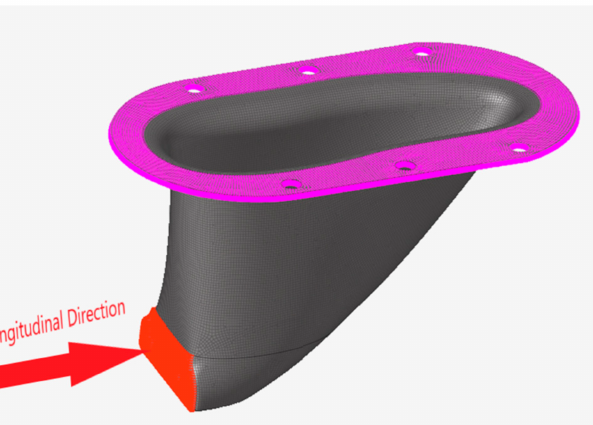
Figure 4. Boundary constraint location at the top of the structure (pink) and load application location on the front, bottom of the structure (red) and the longitudinal load application